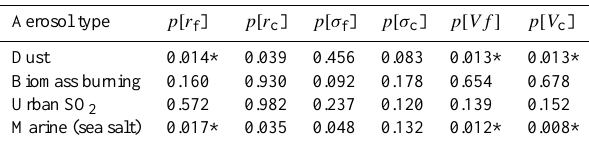
Table 3. The results of applying a two-tailed paired t test at the 95% level of confidence ( p < 0.025) to ascertain whether or not the values of the secondary microphysical parameters obtained by the OEV method are statistically significant from those quoted by AERONET. Cases presenting a statistical difference are indicated by